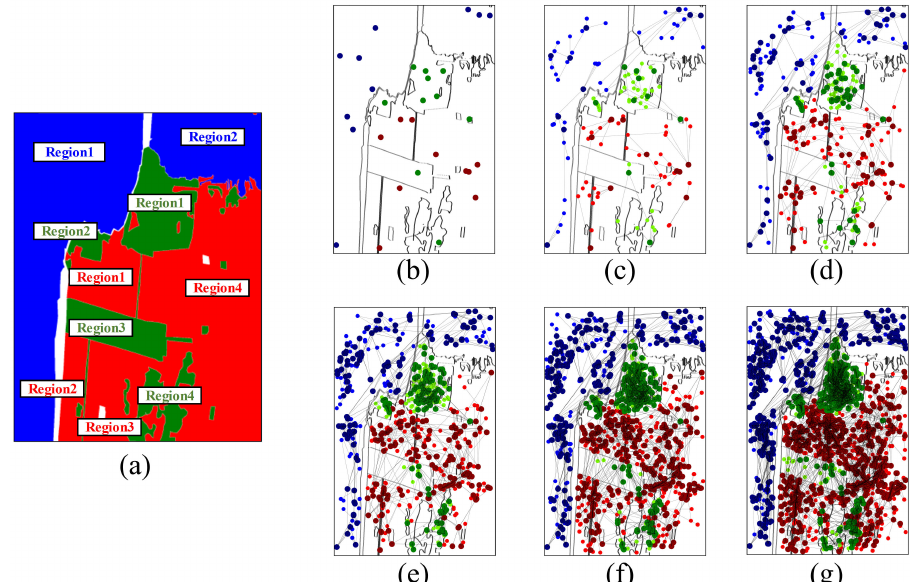
Figure 5. Sample selection. ( a ) Regions of Rs2-Sanf. Each region is separated by other land-cover categories. ( b ) First training set of labeled samples. ( c – g ) Selected samples after one-five selection loops. The small light-colored points are the selected unlabeled samples which are connected to the labeled samples represented by the large dark-colored